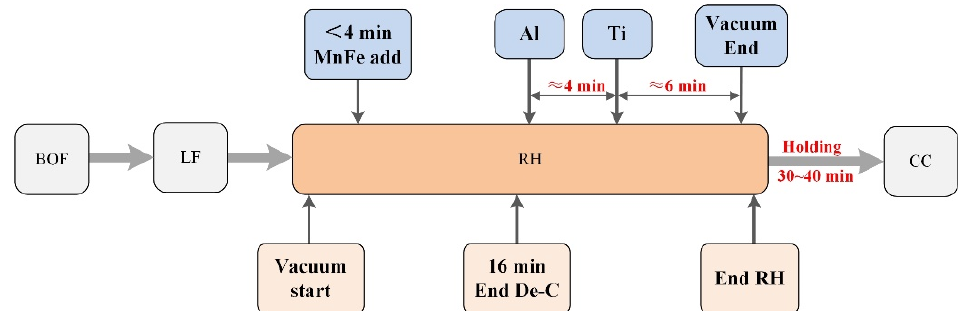
Figure 1. Steps of producing IF steel during steelmaking processes.